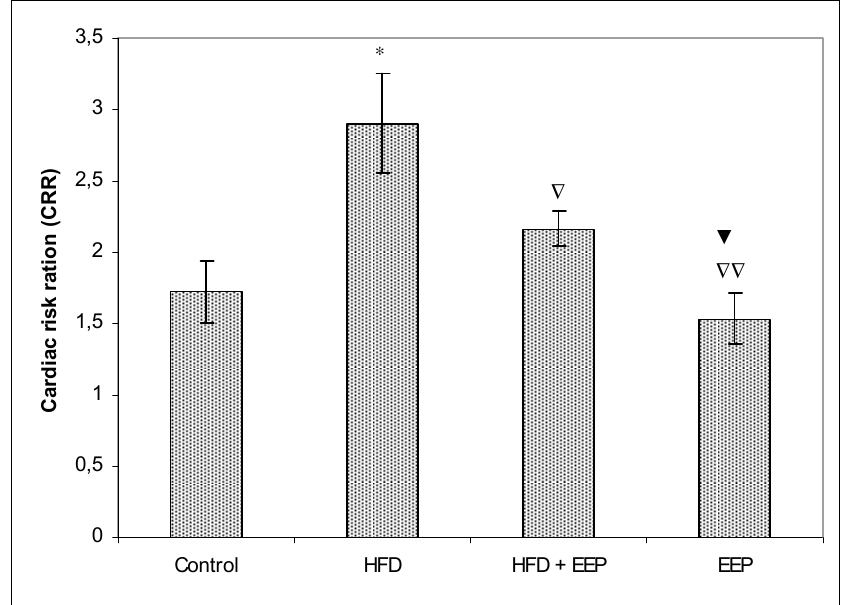
Figure 7. Effect of ethanol extract of propolis on cardiac risk ration (CRR). Mice were given HFD, HFD + EEP at a dose 50 mg/kg or EEP (50 mg/kg) once daily for 30 days by a single intragastric application. Cardiac risk ratio was calculated according to the formula: CRR = [TC/HDL-c]. Number of mice per groups: nine. * Significantly different from the control group (* p ≤ 0.05). ∇ Significantly different from the HFD group ( ∇ p ≤ 0.05; ∇∇ p ≤ 0.01). ▼ Significantly different from the HFD + EEP group ( ▼ p ≤ 0.05).